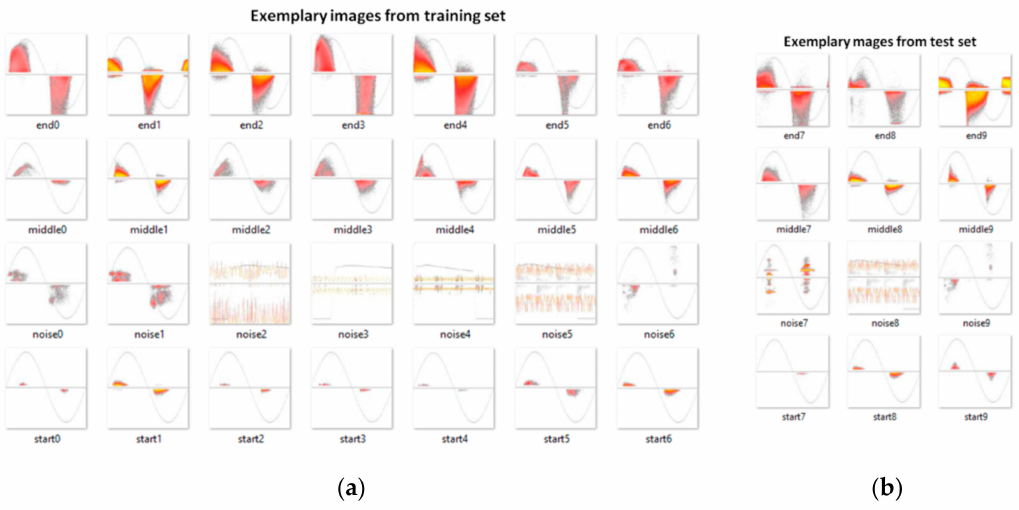
Figure 7. Exemplary set of training ( a ) and test ( b ) partial discharge images exhibiting distinguishable classes (start, middle, end and noise / disturbance) of electrical insulation degradation